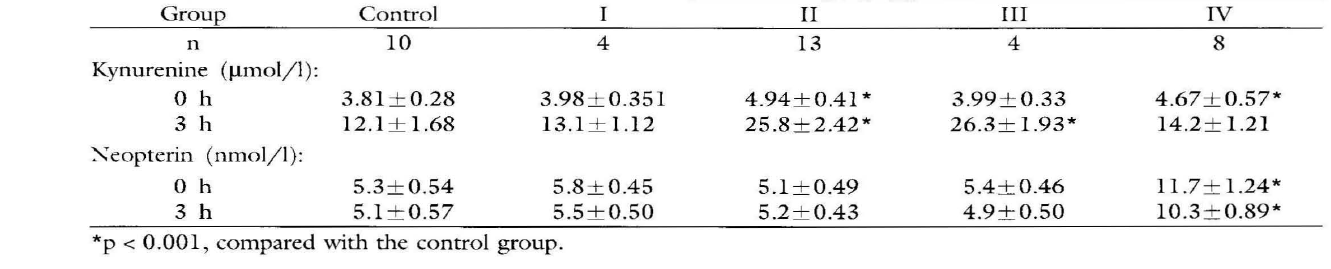
Table 2. Serum kynurenine and neopterin concentrations in control group, in patients with mesangioproliferative glom erulonephritis (MesPG) with proteinuria < 2 g/24 h before and 3 hours after L-tryptophan peroral loading 30 mg/kg body weight: Group I=normal concentrations of serum kynurenine and neopterin; group II=increased levels of serum kynurenine before and 3 hours after L-tryptophan load, normal neopterin concentrations; group III=increased levels of serum kynurenine only 3 hours after L-tryptophan load, normal amount of serum neopterin; and group IV=increased levels of serum kynurenine before L-u-yptophan load; increased levels of serum neopterin before and 3 hours after L tryptophan load (Mean values±S.D . are shown)